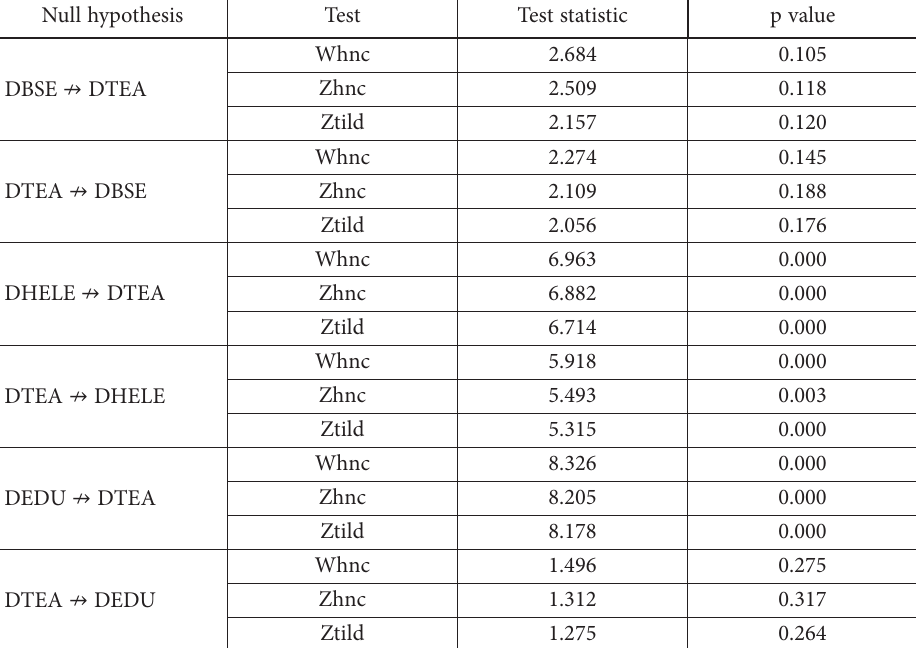
Table 8. Dumitrescu and Hurlin (2012) Granger causality test Null